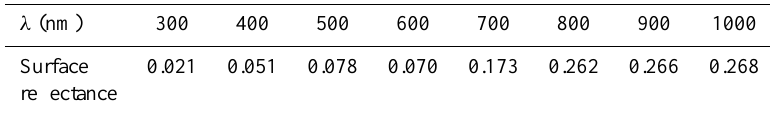
Table 3. The surface reflectances at typical wavelengths.